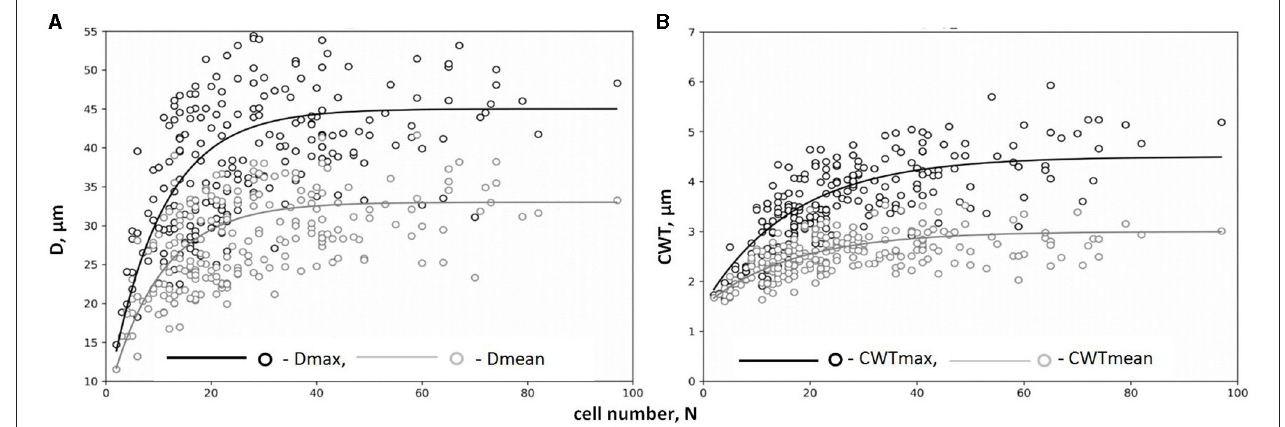
FIGURE 4 | Dependencies of tracheid traits on cell number, N , for maximum and mean values of radial diameter D max ( N ) and D mean ( N ) (A) and cell wall thickness CWT max ( N ) and CWT mean ( N ) (B) (on example of tree #3). Markers of scatter plots (circles) represent actual tree rings; lines represent exponential functions of relationships. Data on maximum values of cell traits ( D max , CWT max ) are presented in black color; data on mean values of cell traits ( D mean , CWT mean ) are presented in gray color.